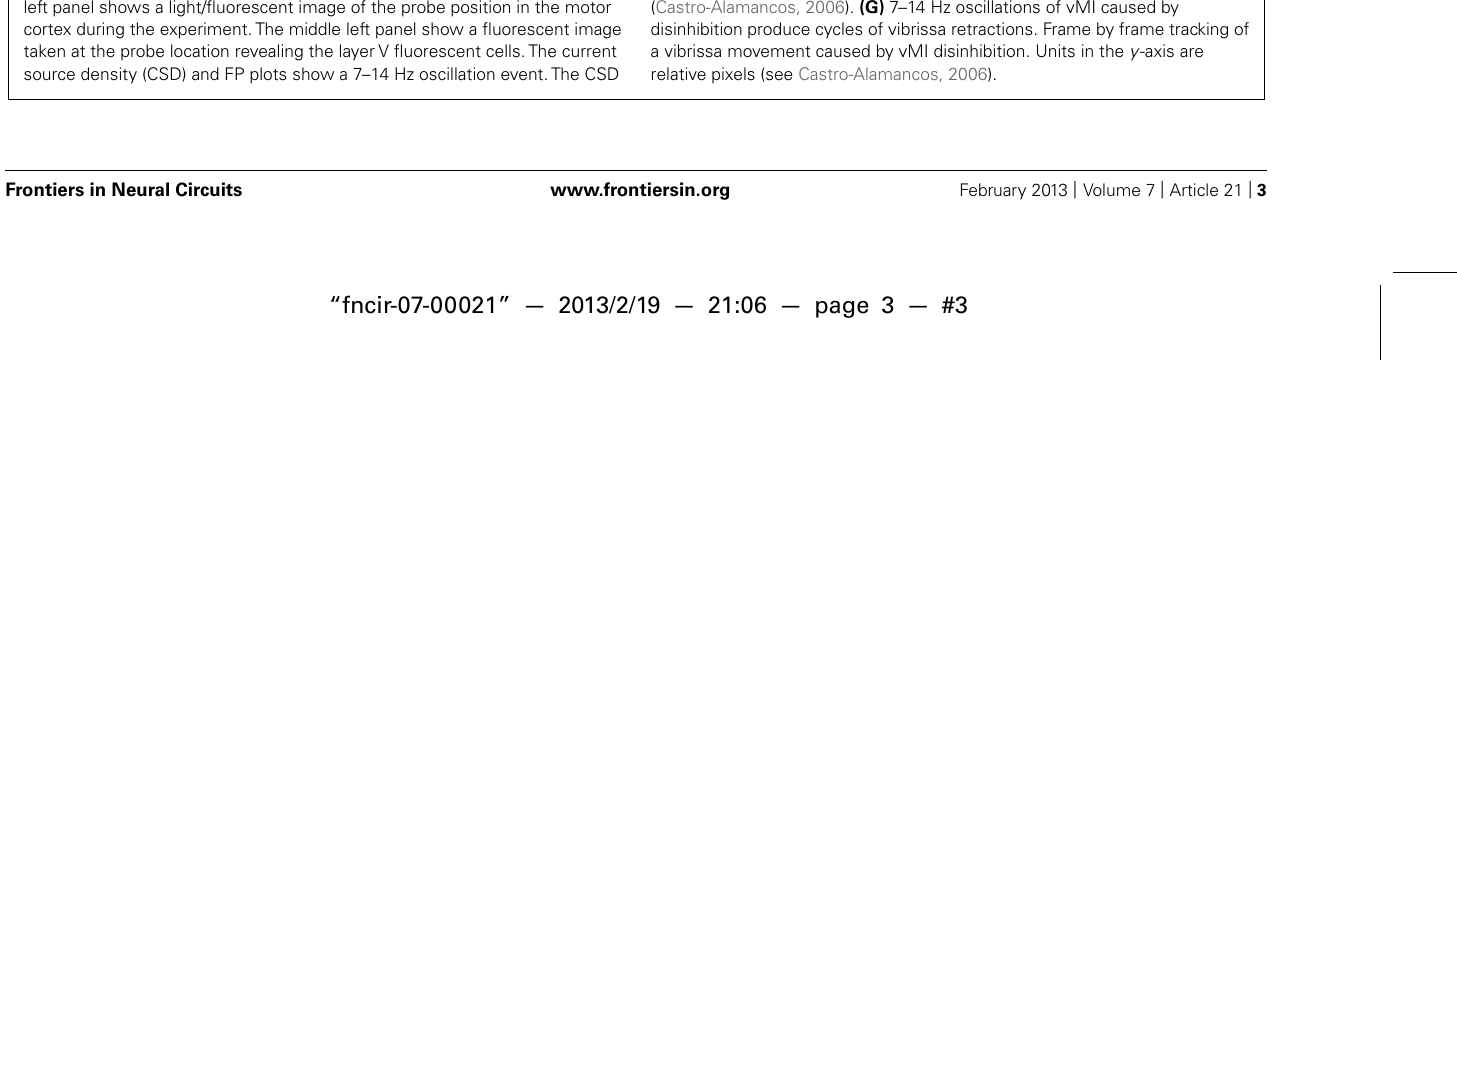
FIGURE 2 | 7–14 Hz oscillations are caused by low [Mg 2 + ] o buffer or disinhibition in the motor cortex but not in the somatosensory cortex. (A–C) Field potential (FP) recordings in neocortical slices showing typical spontaneous events recorded in motor (agranular) cortex (left panels) and in somatosensory (granular) cortex (right panels) during block of GABA A receptors with bicuculline (BMI) (A) , subsequent lowering of [Mg 2 + ] o (B) , or subsequent block of GABA B receptors (C) . Note the occurrence of 7–14 Hz oscillations only in agranular cortex. In each panel, the upper trace has a long time scale and the lower trace shows a close-up of a spontaneous discharge (Castro-Alamancos andTawara-Hirata, 2007). (D) Recording from a fluorescent slice of anThy1-eYFP mouse using a 16-channel silicon probe.The left panel shows a light/fluorescent image of the probe position in the motor cortex during the experiment.The middle left panel show a fluorescent image taken at the probe location revealing the layerV fluorescent cells.The current source density (CSD) and FP plots show a 7–14 Hz oscillation event.The CSD